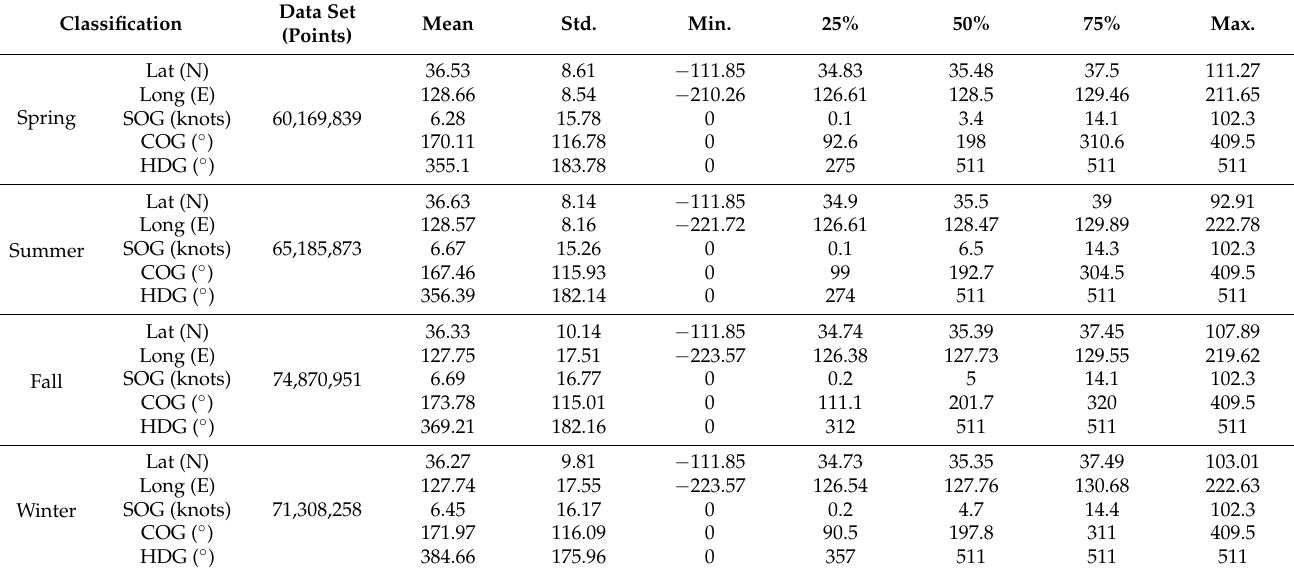
Table 2. Statistical analysis results using raw AIS data.